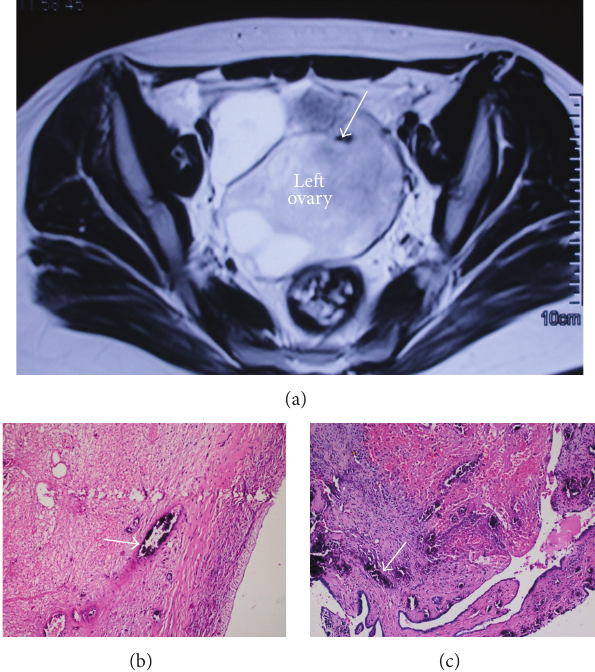
Figure 1: (a) Pelvic axial magnetic resonance imaging of the torsioned left ovary. T2w image showing the well-defined heterogeneous, hyperintense, enlarged left ovary along with a hypointense focus corresponding to the calcification (arrow) on the left upper peripheral border of enlarged ovary. (b) and (c) The microscopic views of dystrophic microcalcifications of the left ovary (b) and the left tuba uterina (c) stained with